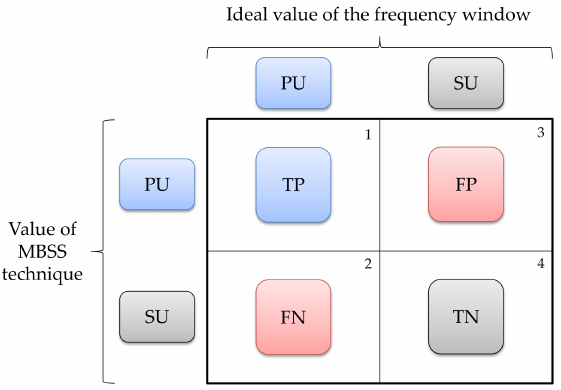
Figure 19. Classification of windows detected by the MBSS technique.